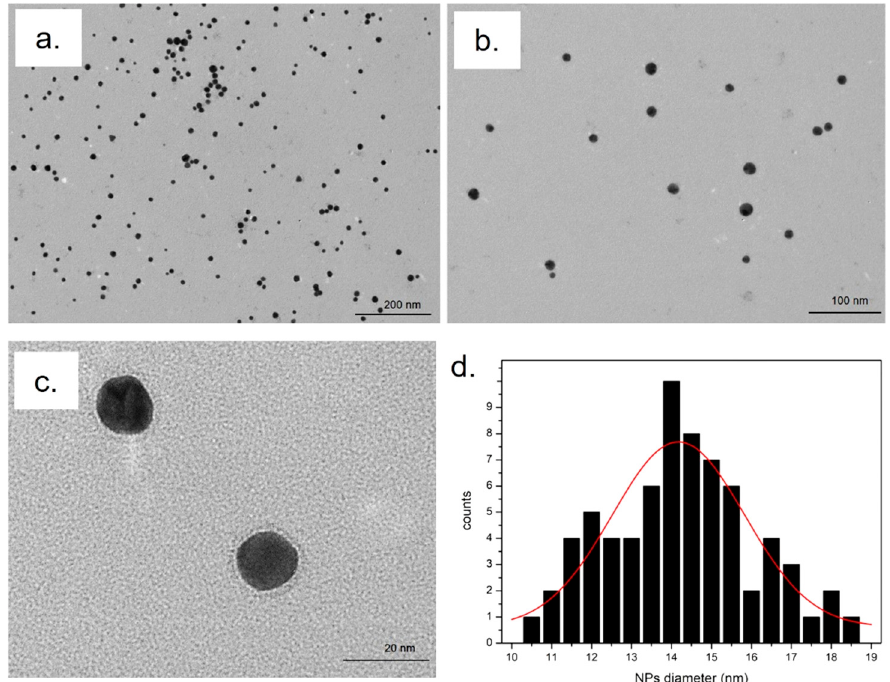
Figure 3. TEM images of AuNPs@CS-FITC obtained by microwave eco-friendly synthesis at different magnifications: 200 nm ( a ), 100 nm ( b ), and 20 nm ( c ). Statistical analysis with Gaussian fit (red line) for AuNPs@CS-FITC ( d ).